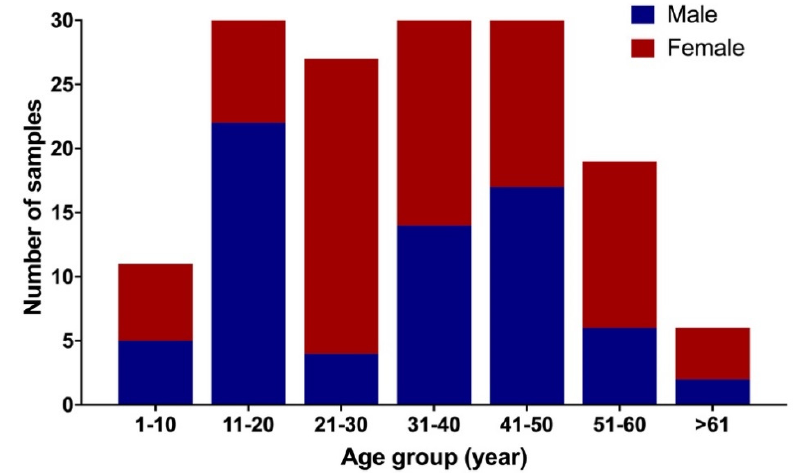
Figure 1. Number of participants based on age and gender ( n = 199).